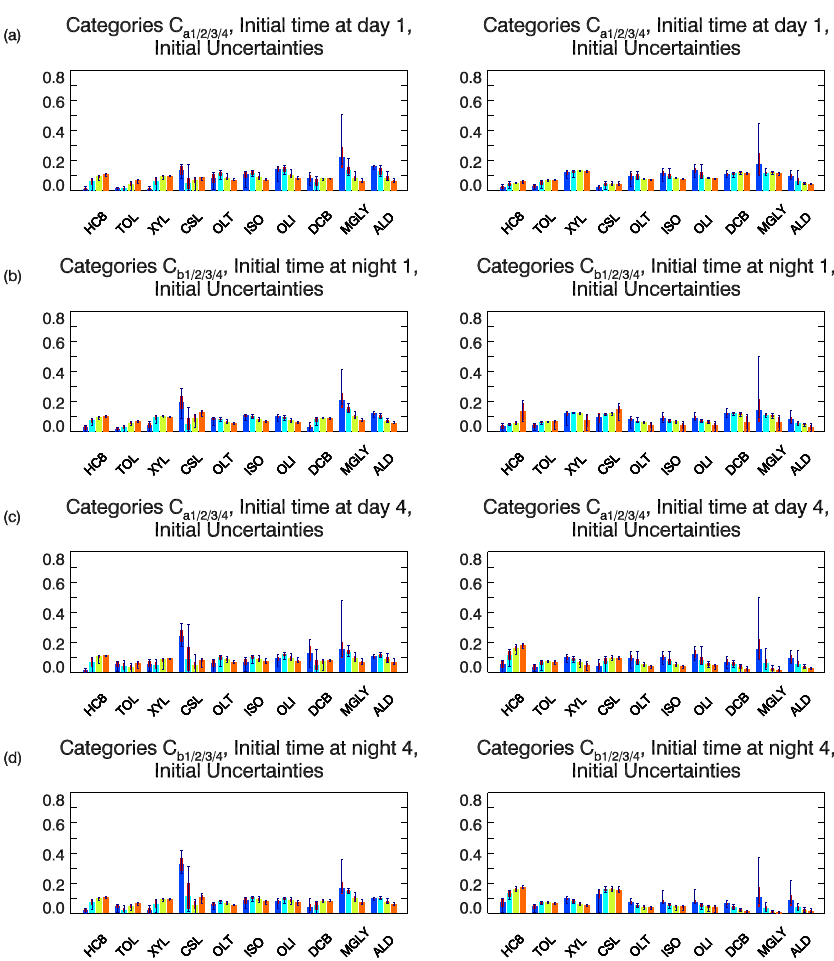
Fig. 5. Statistics of adjoint sensitivities with respect to initial uncertainties for scenario PLUME (left panel column) and scenario URBAN (right panel column) for (a) day 1, (b) night 1, (c) day 4, and (d) night 4. Displayed are results for categories C a 1 VOCs with the most influence. All panels depict mean impact ( C a/b : blue bars, C a 1 /b 1 : blue bars, C a 2 /b 2 : turquoise bars, C a 3 /b 3 : green bars, C a 4 /b 4 : orange bars), minimum/maximum value (dark blue lines) and standard deviation (red bars).